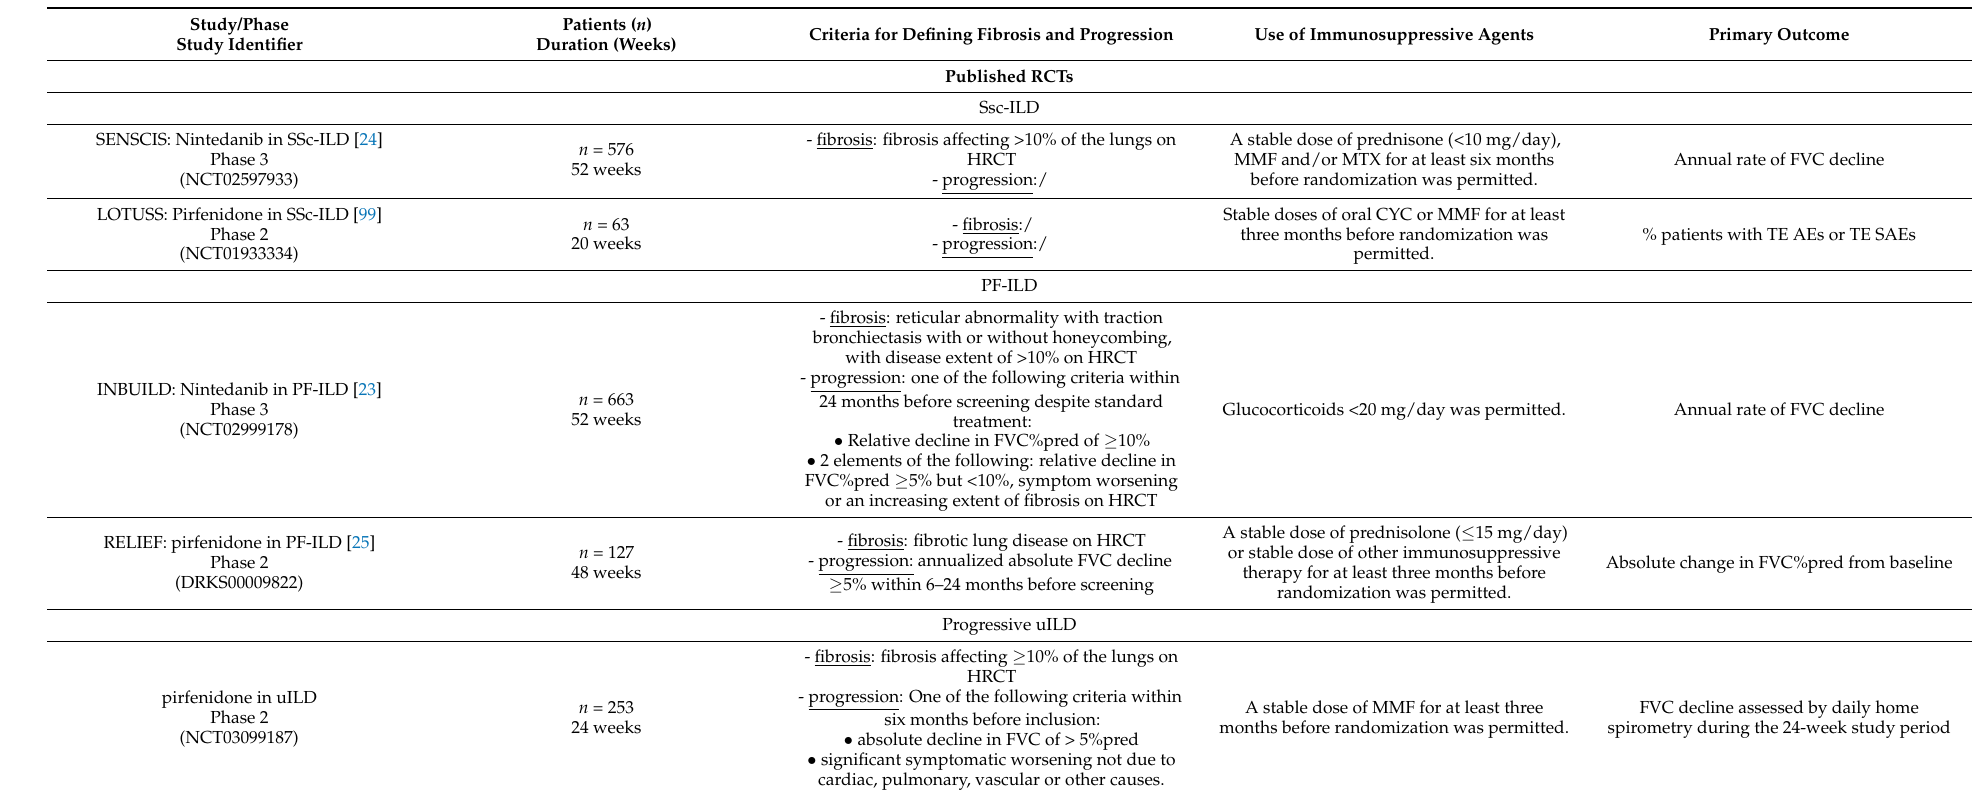
Table 1. Randomized clinical trials with antifibrotics among patients with (progressive) fibrosing